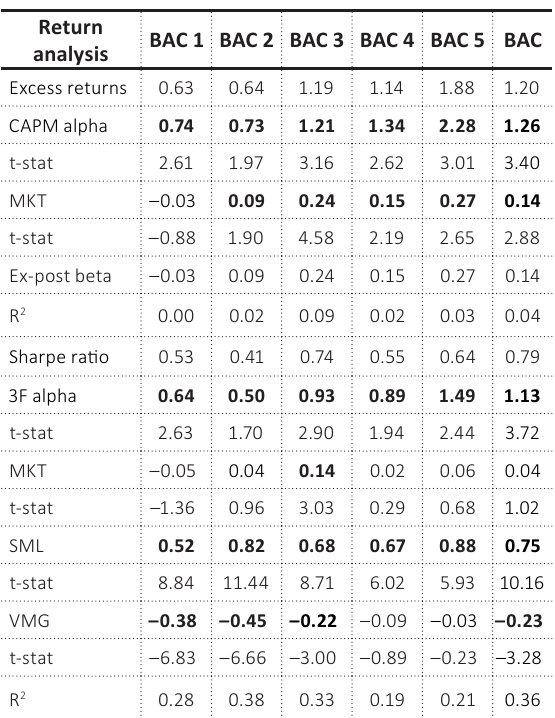
Table 4. Betting against correlation (BAC)